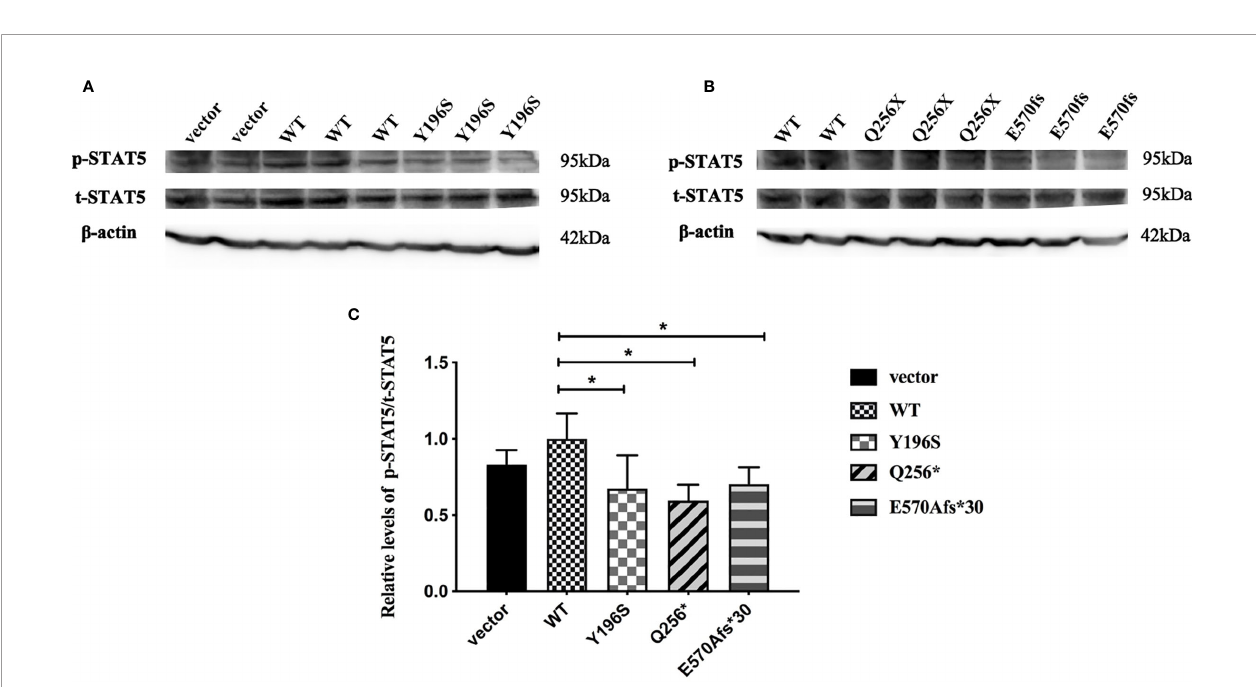
FIGURE 5 | Phosphorylated STAT5 (p-STAT5) expression in HepG2 cells transfected with wild type GHR (WT), mutant GHR Y196S, Q256* and E570Afs*30 after 100ng/ml rhGH was added in the cell culture medium for 30 minutes. Both p-STAT5 and total STAT5 (t-STAT5) had a molecular weight of around 95 kDa (A, B) . The ratio of p-STAT5 to t-STAT5 was converted to gray-scale value by Image J. The expression of p-STAT5 was signi fi cantly decreased in GHR -Y196S, GHR - Q256* and GHR -E570Afs*30 when compared to GHR -WT as shown in (C)